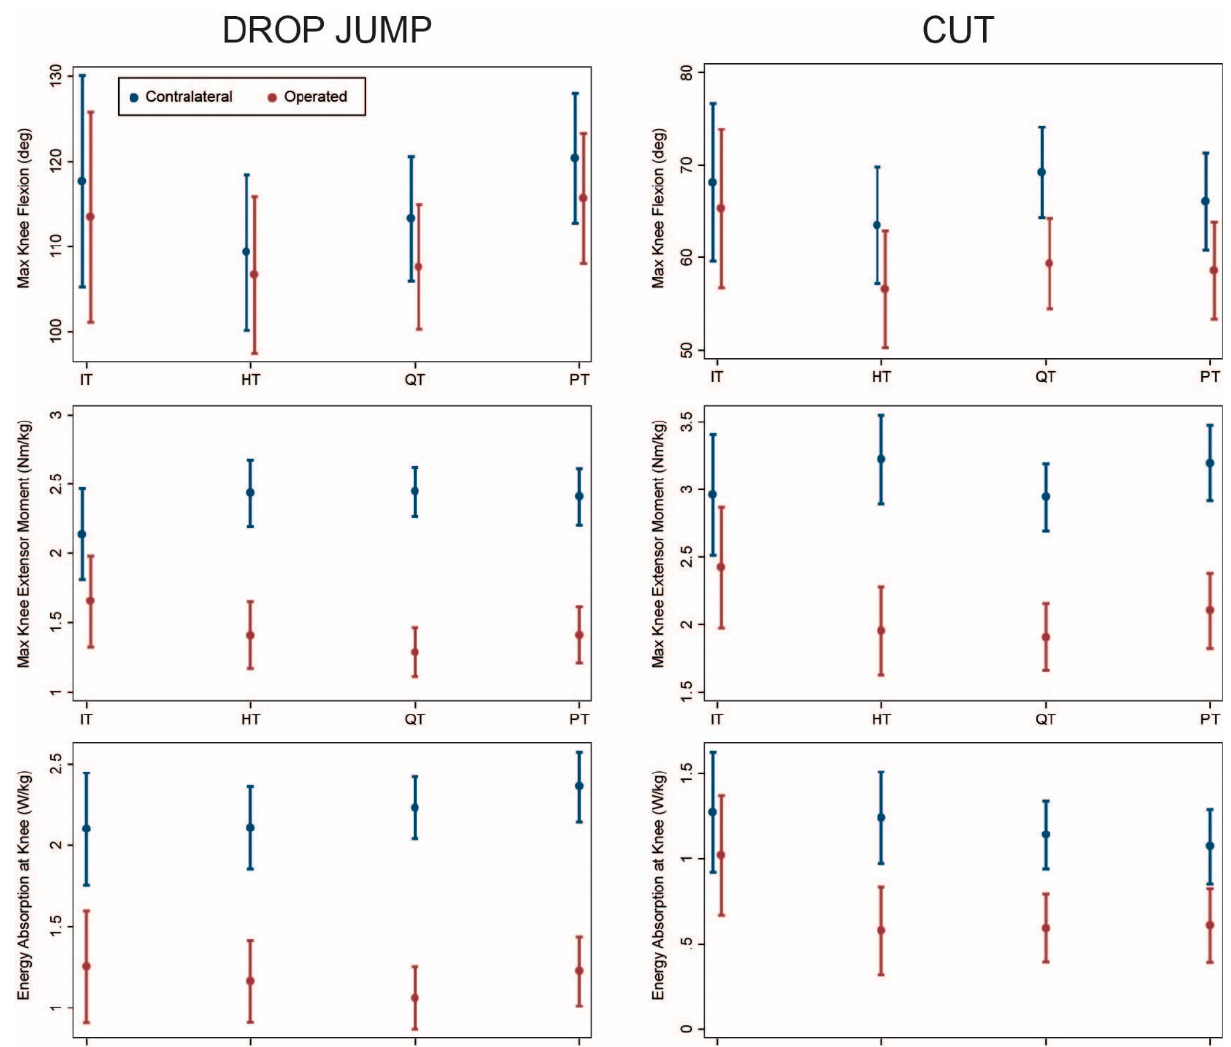
Figure 3. Comparison of operated (red) and contralateral (blue) limbs by graft type (model predicted mean and 95% confidence interval) for patients with concomitant meniscus procedures. IT: iliotibial band; HT: hamstring tendon; QT: quadriceps tendon; PT: patellar tendon.